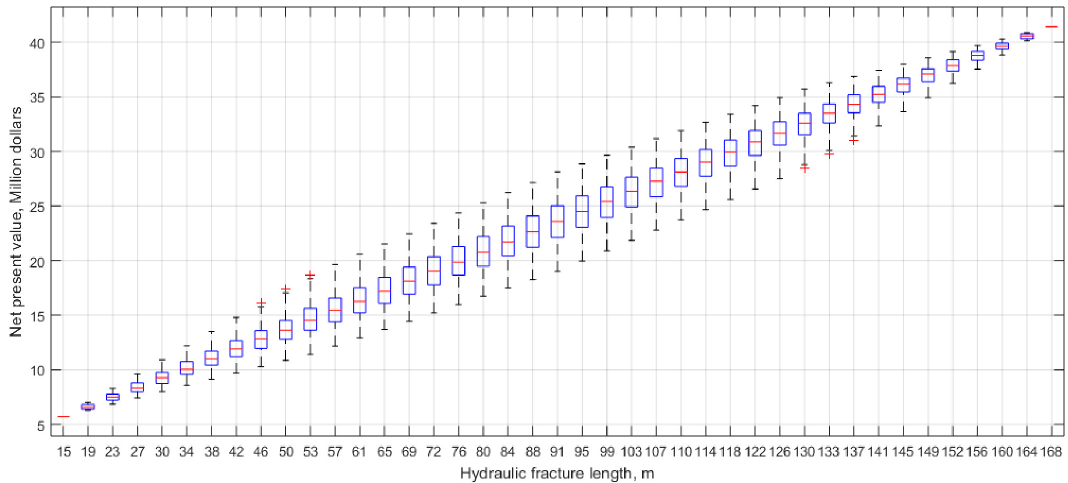
Figure 11. Net present values of each hydraulic fracture design.